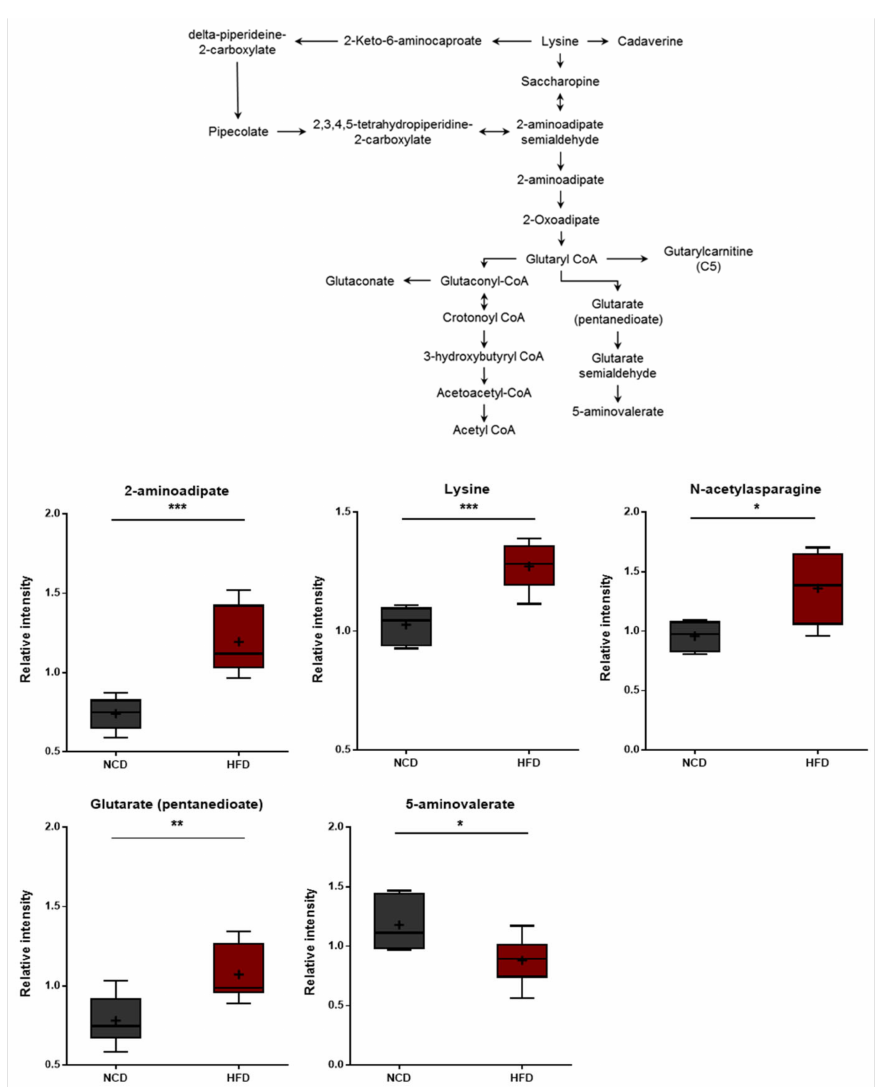
Figure 7. Pathway of statistically significant biochemicals profiled between NCD group and HFD group. Metabolites involved in the lysine metabolism were altered in the HFD group. Data were presented as mean ± SD ( n = 6) and two-way ANOVA with Bonferroni’s multiple comparison test. * p < 0.05; ** p < 0.01; *** p <